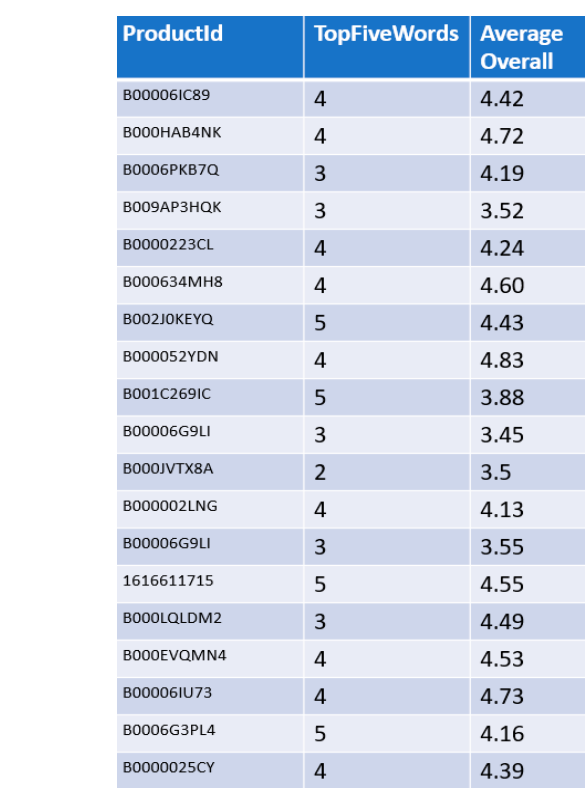
Figure 8. Relation between TopFiveWords and average overall of each Product.